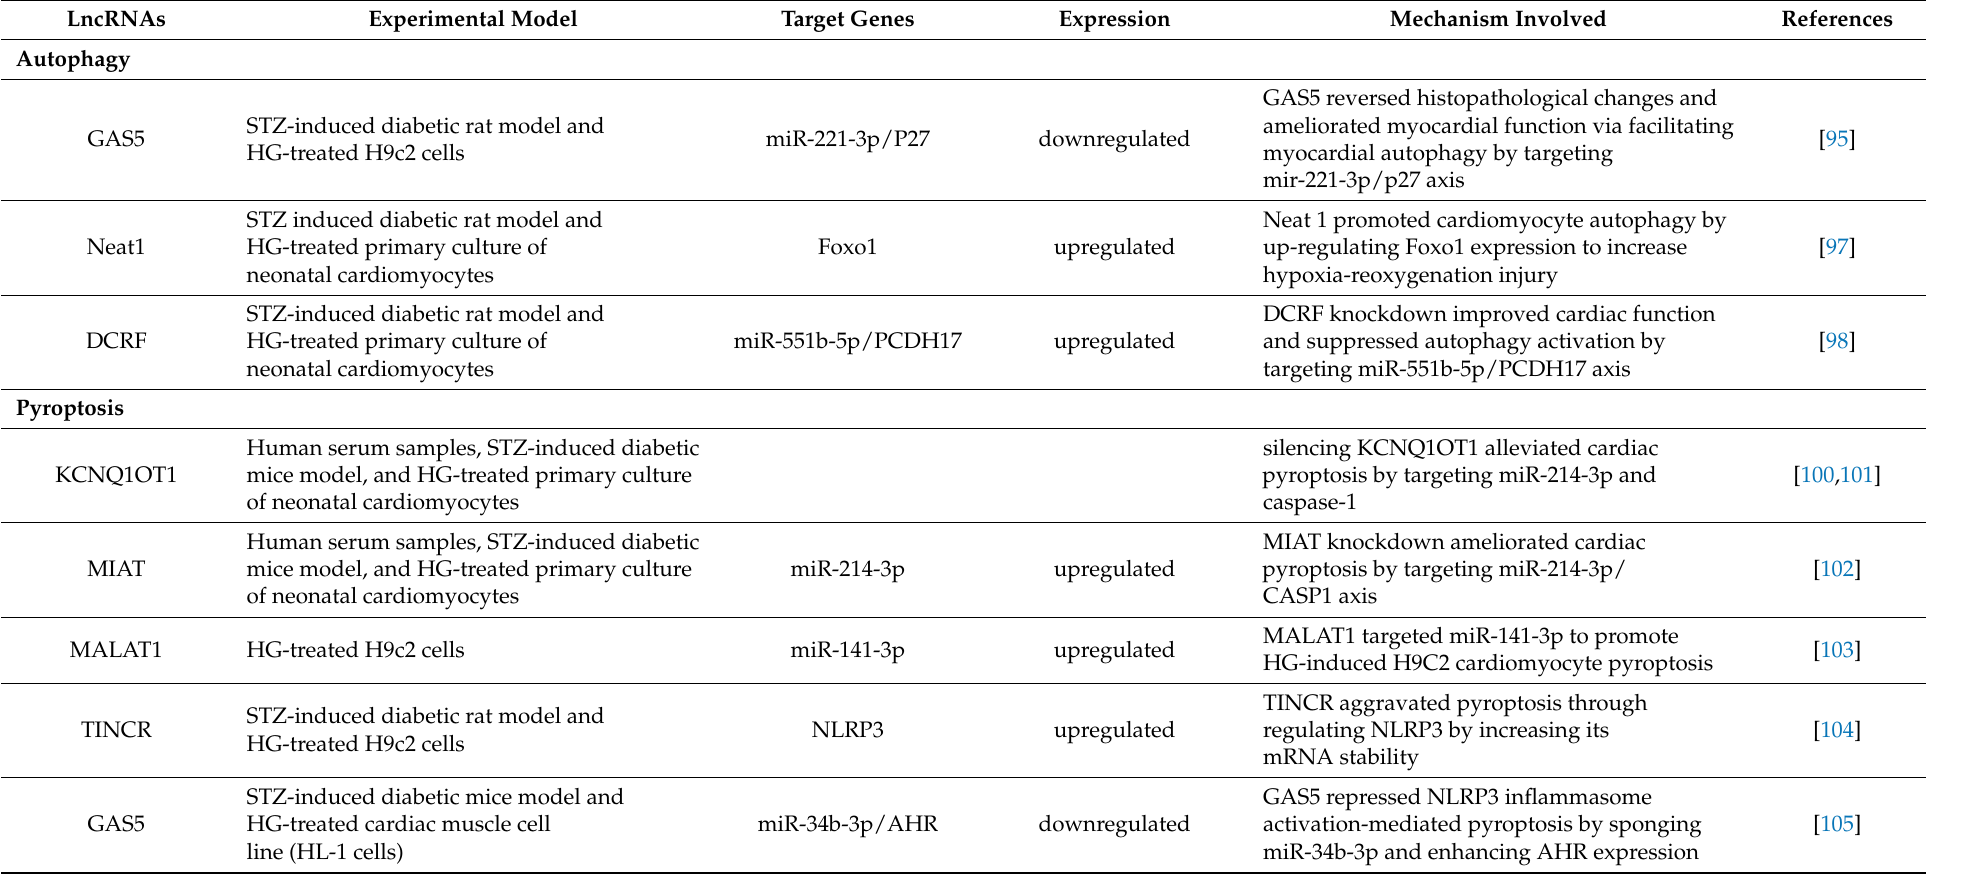
Table 2. LncRNAs participating in the regulation of myocardial autophagy and pyroptosis in